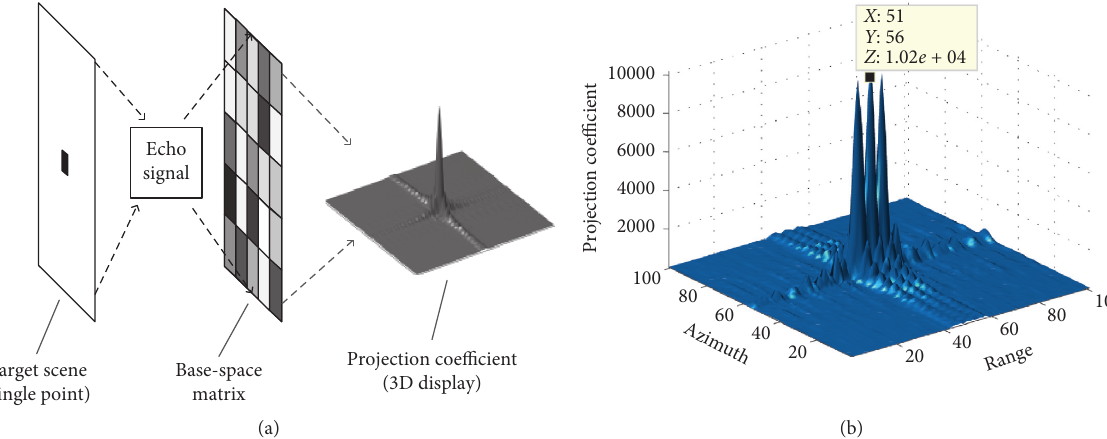
Figure 4: Sidelobe filtering based on Gaussian weighting. (a) Schematic of base-space projection. (b) Schematic of sidelobe superposition of scattering points.